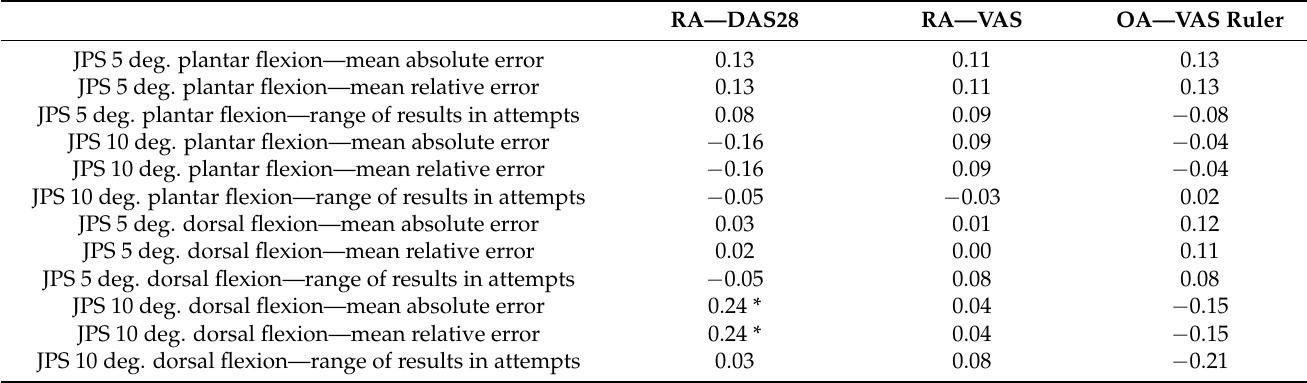
Table 5. Correlation coefficient r between DAS28, VAS ruler, and JPS in RA and OA groups. RA—DAS28 RA—VAS